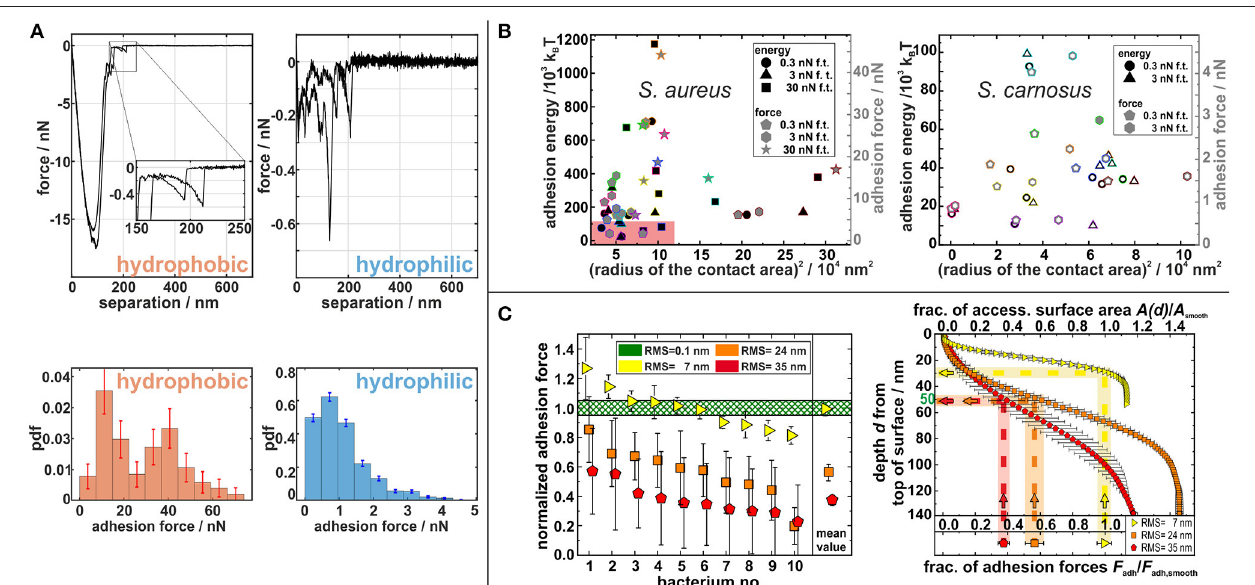
FIGURE 2 | (A) Exemplary force–distance curves (upper row) and probability density function of adhesion forces (lower row) from SCFS with S.aureus cells (Maikranz et al., 2020 ). (B) Adhesion energy (black symbols) and adhesion force (gray symbols) of S.aureus (left) and S.carnosus (right) in dependence of their contact radius squared. The reddish rectangle displays the size of the complete right graph (Spengler et al., 2017). (C) (Left) Experimentally determined adhesion forces for 10 individual cells each on different rough substrata. (Right) Correlation of adhesion force and accessible surface area in dependence of the depth from the top of the rough surface ( Spengler et al.,